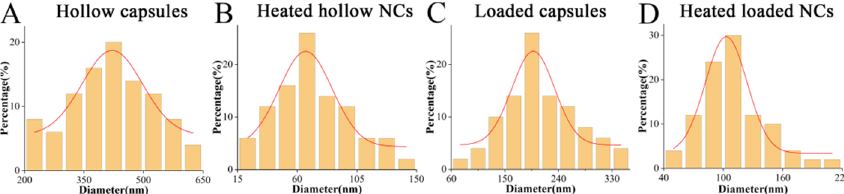
Figure 2. Granulometric distribution of ( A ) hollow capsules, ( B ) heated hollow NCs, ( C ) loaded capsules and ( D ) heated loaded NCs.